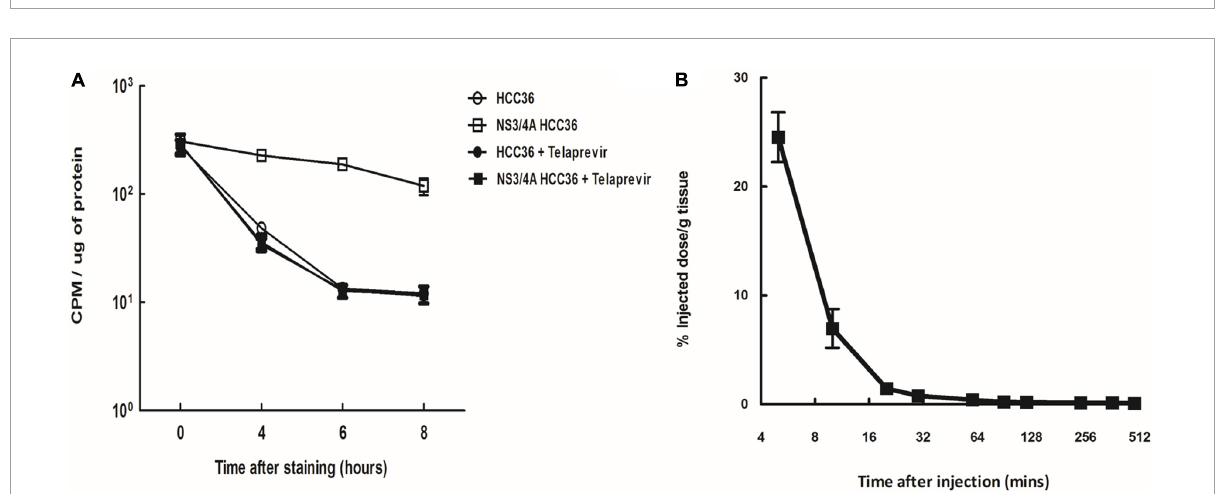
FIGURE4 Specificity and half-life of TAT- (cid:49) NS3/4A- 124 I-FITC. (A) NS3/4A-HCC36 and HCC36 cells were incubated with 37 kBq of TAT- (cid:49) NS3/4A- 124 I-FITC in the presence or absence of 2 µ M Telaprevir at 37 ◦ C for 1 h. The cells were washed with DMEM containing 10% serum three times per hour. The cells were collected by treatment with trypsin at the indicated times. The radioactivity of the cells was then measured with a gamma-counter. The CPM was normalized by protein concentration. (B) Kinetics of the TAT- (cid:49) NS3/4A- 124 I-FITC in vivo , BALB/c mice were intravenously injected with TAT- (cid:49) NS3/4A- 124 I-FITC, and the radioactivity in serum samples collected at the indicated times was measured using a gamma-counter. t 1 / 2 = 2.55 min. Error bar: standard error of triplicate